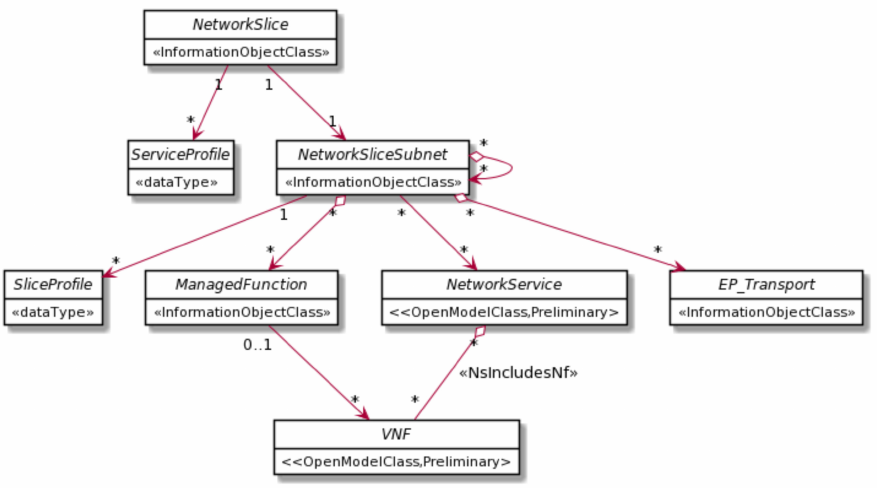
Figure 3. Network Slice NRM relationship [20]. Note * denotes zero or